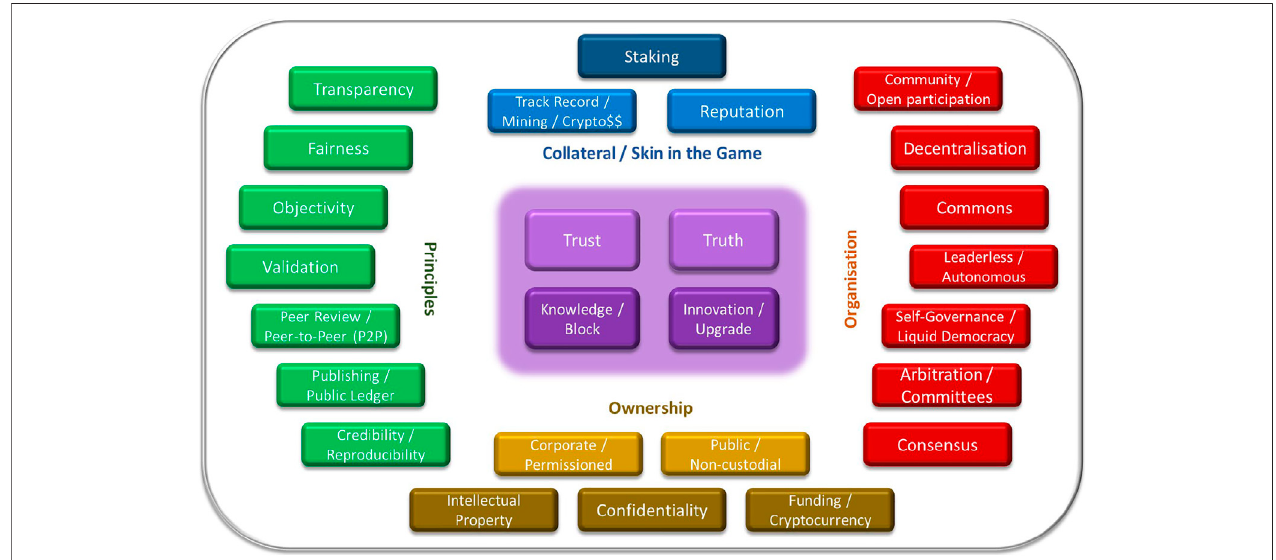
FIGURE 1 | Buzz words in science and RTD which directly connect to equivalent elements in blockchain technology. The central objective is to create blocks of trust and truthful knowledge/innovation and logthemapublic orpermissionedledger. Credibility ofcontributionsisrewardedand stakedbyworkefforts andreputation. Ownership and con fi dentiality ofresultsdependon thesource offunding,and may be kept ascorporatesecret ormade public.Theconstruct isframed bymechanisms to assure quality and credibility of results on the left and involvement of the community on the right-hand side.